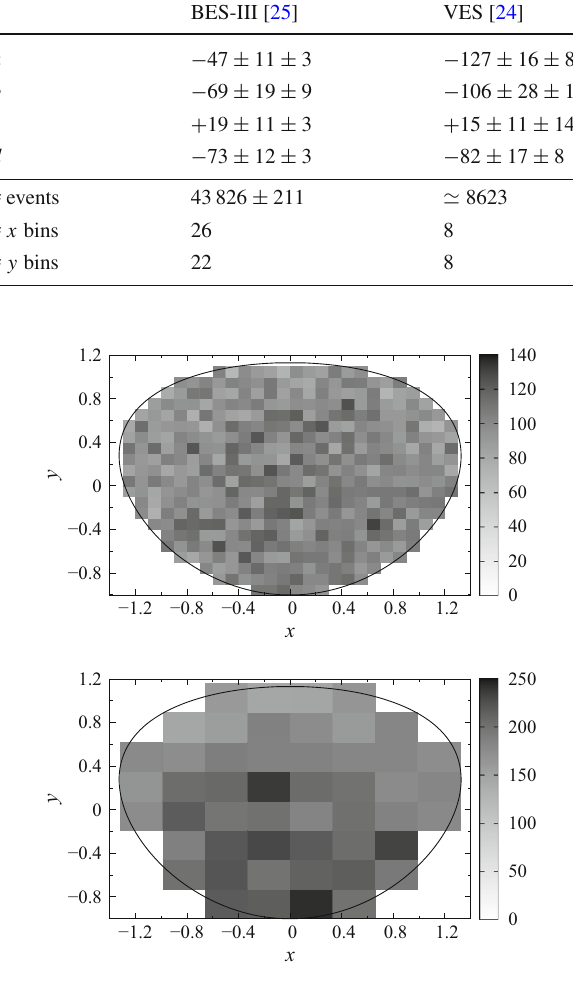
Fig. 5 Dalitz-plot samples for η (cid:2) → ηπ + π − from the experimental Dalitz-plot distribution in Table 1 for the BES-III ( top panel ) and the VES ( bottom panel )